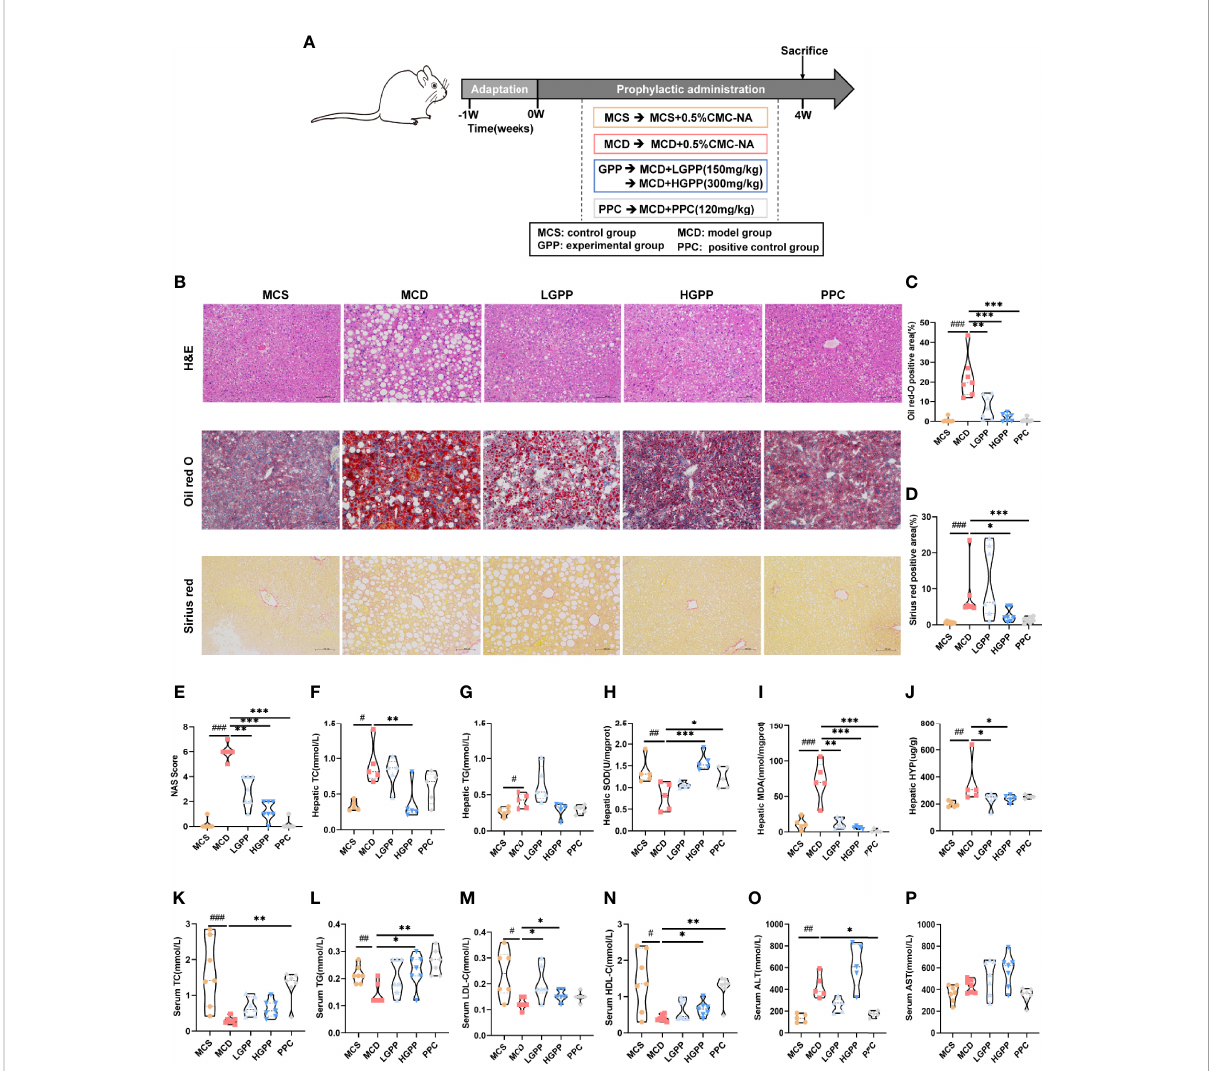
FIGURE 2 GPP alleviated methionine-choline-de fi cient (MCD)-induced non-alcoholic steatohepatitis (NASH) (n = 5 – 7). (A) Study design. (B) Representative photomicrographs of liver tissue with H&E (magni fi cation, ×200, 100 m m) and Oil Red O staining (magni fi cation, ×200, 100 m m) and Sirius Red staining for liver sections (magni fi cation, ×200, 100 m m). (C) Histomorphometric analysis of the positive area with Oil Red O staining and (D) Sirius Red staining. (E) Non-alcoholic fatty liver disease (NAFLD) Activity Score (NAS). (F – J) Hepatic total cholesterol, triglycerides, superoxide dismutase, malondialdehyde, and hydroxyproline (TC, TG, SOD, MDA, and HYP, respectively). (K – P) Serum TC, TG, low- and high-density- lipoprotein cholesterol, alanine transaminase, and aspartate aminotransferase (LDL-C, HDL-C, ALT, and AST, respectively). Data are expressed as median and interquartile range (IQR). * P < 0.05, ** P < 0.01 and *** P < 0.001 vs. the MCD group; # P < 0.05, ## P < 0.01, and ### P < 0.001 vs. MCS group. One-way ANOVA test followed by a least signi fi cant difference (LSD) (H, P) , Kruskal – Wallis test (C – G, I – O) . MCS,